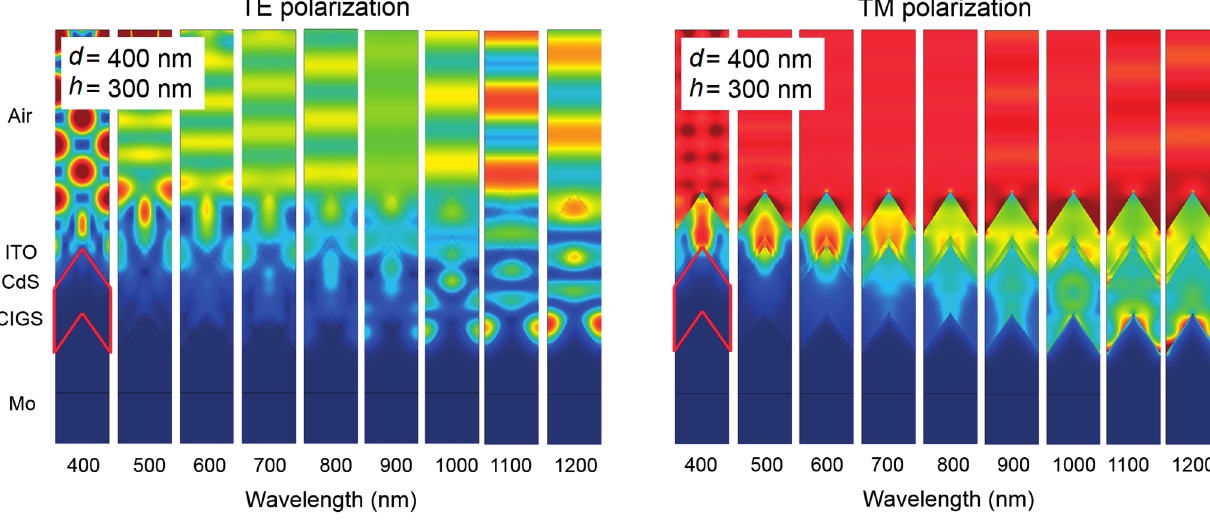
Figure 4. Simulation results of the triangular structuring with texture height and period of h = 300 nm and d = 400 nm, for both TE and TM